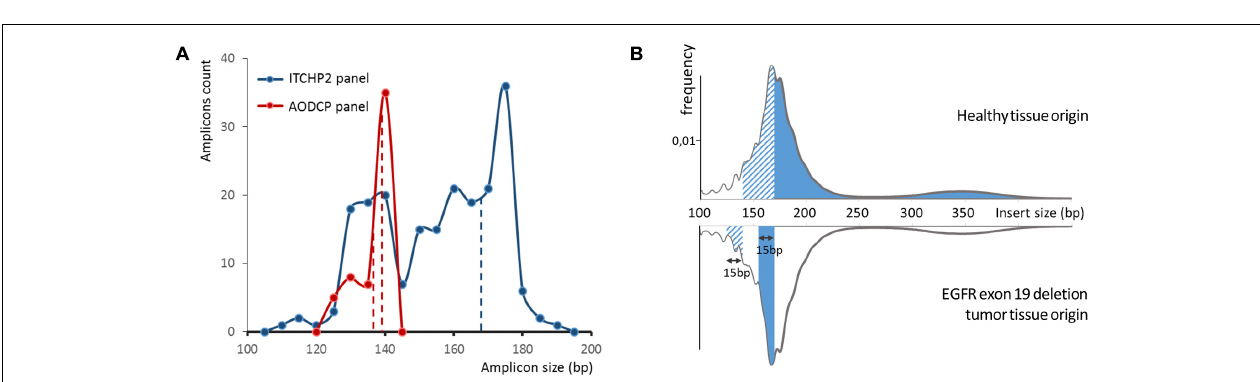
FIGURE 1 | Samples used for data analysis as well as mutations identified during NGS sequencing and allele frequencies thereof (plasma EGFR status). Mutations identified employing a conventional sequencing method indicated in the tumor alteration column while its match (green) or mismatch (red) with NGS results specified in plasma EGFR status